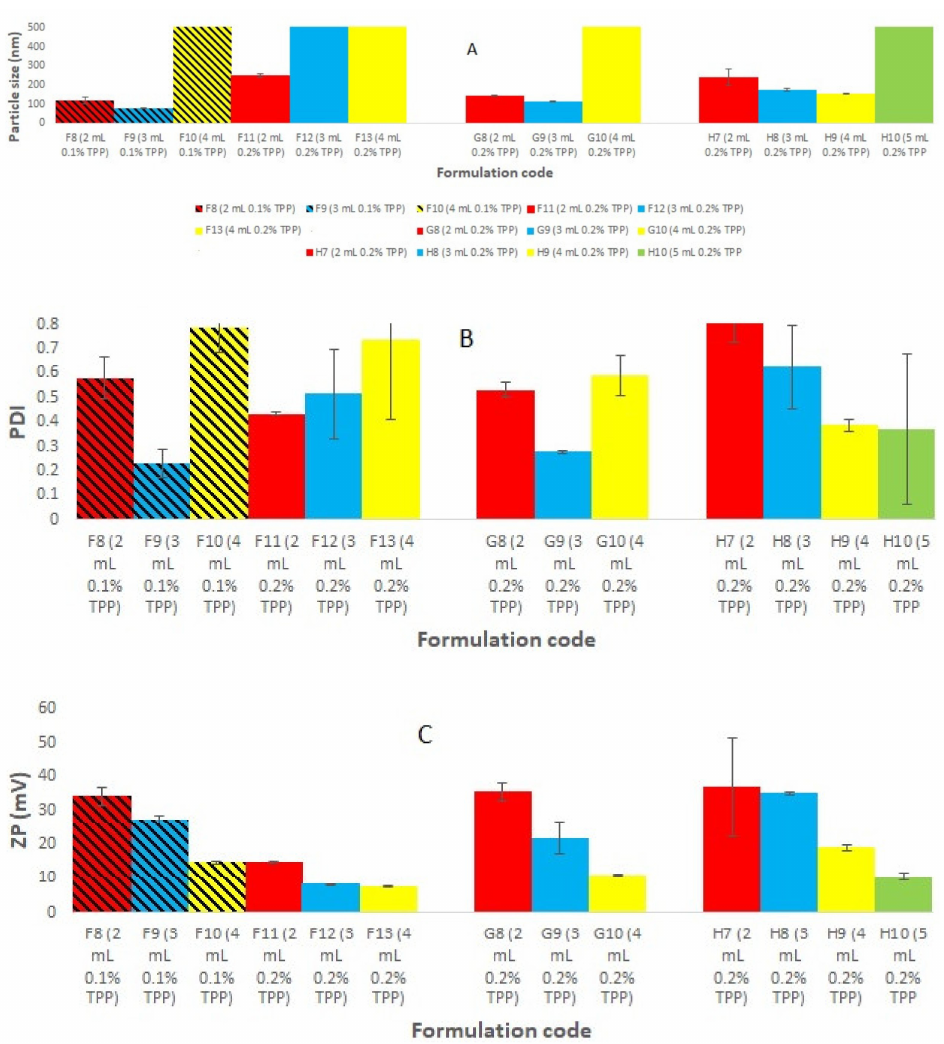
Figure 2. Represents the effect of increasing the TPP concentration and reducing the volume of TPP on ( A ) PS, ( B ) PDI, and ( C ) ZP at a fixed concentration of CS to exclude the effect of the TPP